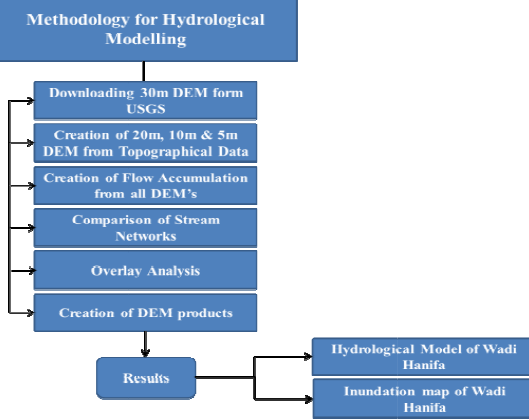
Figure 2. Showi Tremendous g engineering ind terrain data. Th manage all infra by new spatia include